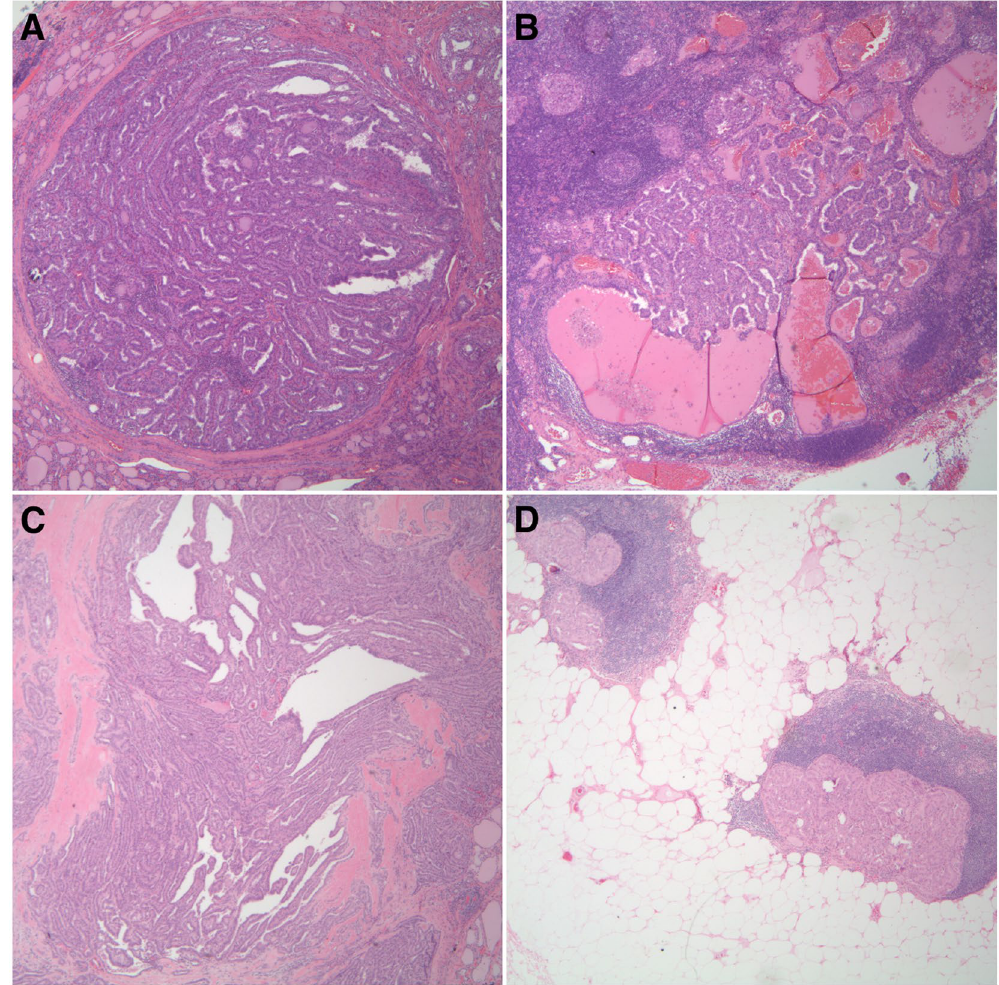
Figure 4. Histopathological examination of two PTC tissues. H&E staining (x100) shows ( A ) and ( B ) Representative case of mutant BRAF in primary cPTC (size = 3 cm and age = 28 years-old) and the corresponding paired lymph node metastasis ( 40x ). ( C ) Primary PTMC (size = 0.7 cm and age = 33 years) with a mutant BRAF and ( D ) paired lymph node metastasis ( 40x